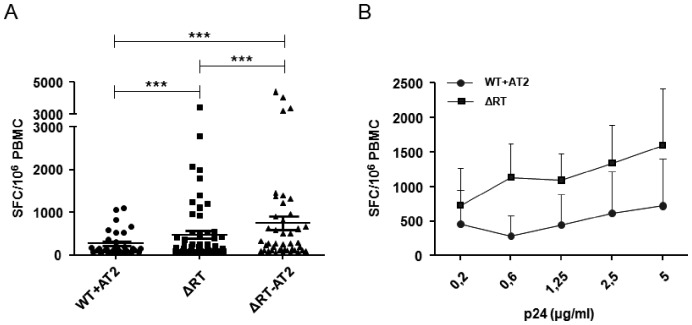
Immunogenicity of different viral constructions measured by ELISPOT responses.(A) Cryopreserved PBMCs from asymptomatic HIV seropositive individuals were tested for specific IFN-γ secreting T cells by in vitro stimulation with different HIV virions (WT+AT-2, ΔRT and ΔRT+AT-2). PBMCs were pulsed with 200 ng/ml p24 equivalents in all cases. The response elicited by WT+AT-2, ΔRT and ΔRT+AT-2 virions (mean ± SEM) is shown. The positivity threshold for each construct or antigen was defined as at least 50 SFC/106 PBMC and at least twice that of the control medium. The magnitude of response differed significantly between stimuli (***p<0.001). (B) Four responder individuals were tested with different concentrations of WT+AT-2 and ΔRT virions (from 200 ng/ml to 5 µg/ml). The titration showed that the difference found between both stimuli was maintained, independently of the amount of virions used.